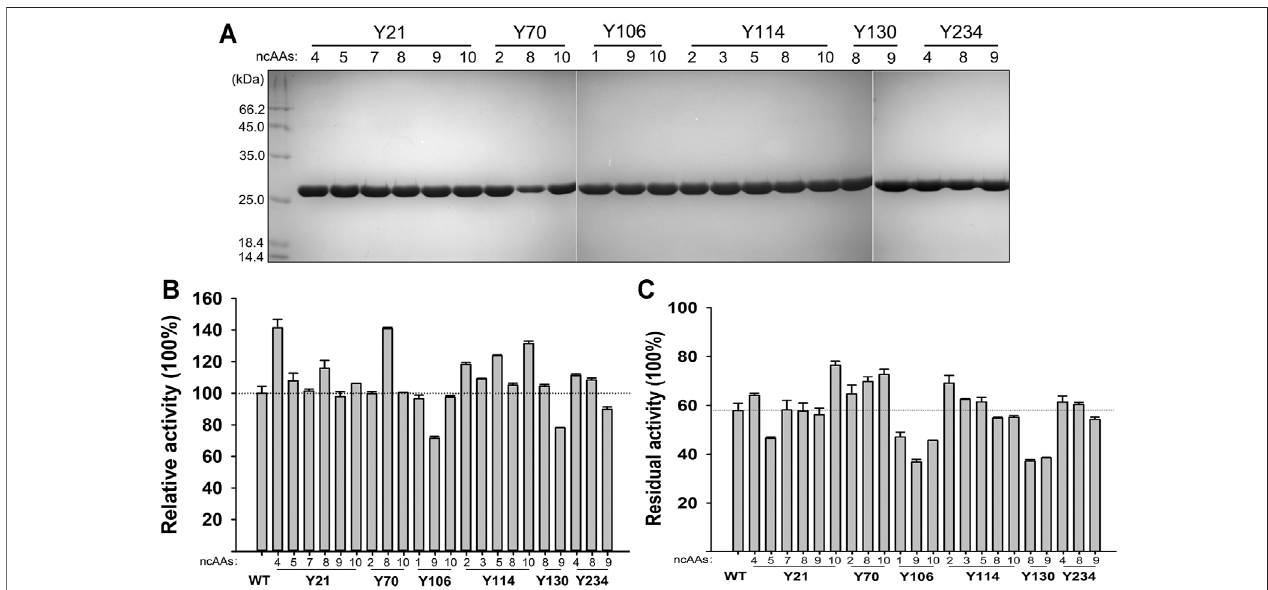
FIGURE 5 | Properties of selected non-canonical amino acids (ncAAs) containing variants. (A) SDS-PAGE analysis of puri fi ed samples of variants. (B) Activities of variants. Azocaseinolytic activities of puri fi ed enzyme samples were determined at 55 ° C in Phosphate Buffer (PB), and relative activity was calculated by de fi ning activity of Wild-Type (WT) as 100%. (C) Thermostabilities of variants. Puri fi ed enzyme samples were incubated at 65 ° C for 30 min, and then standard activity assay was performed using azocasein as substrate. Residual activity is expressed as percentage of original activity of each enzyme sample. Values are means ± Standard Deviations (SD) of three independent